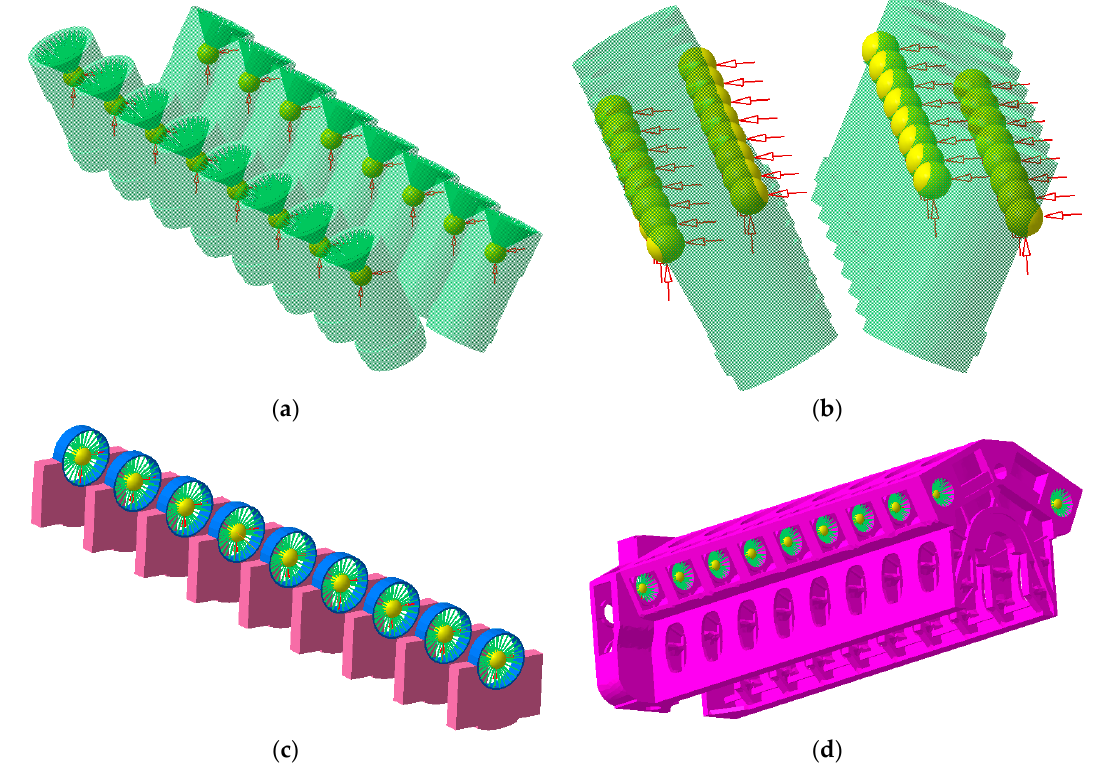
Figure 7. Four loads considered in this study. ( a ) Cylinder pressure; ( b ) Piston side thrust; ( c ) Main bearing force; ( d ) Camshaft force.